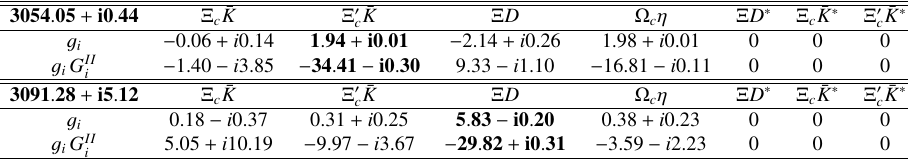
G II i i in MeV.